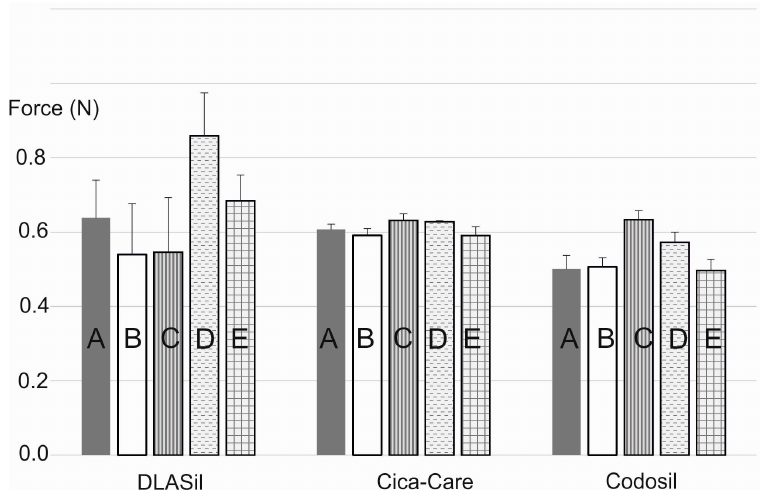
Figure 8. Adhesiveness of DLASil, Cica-Care, and Codosil exposed to storage conditions: ( A ) standard; ( B ) accelerated; ( C ) refrigeration; ( D ) UV exposure; ( E ) 10-fold wash (mean values ± standard deviation, n ≥ 10).